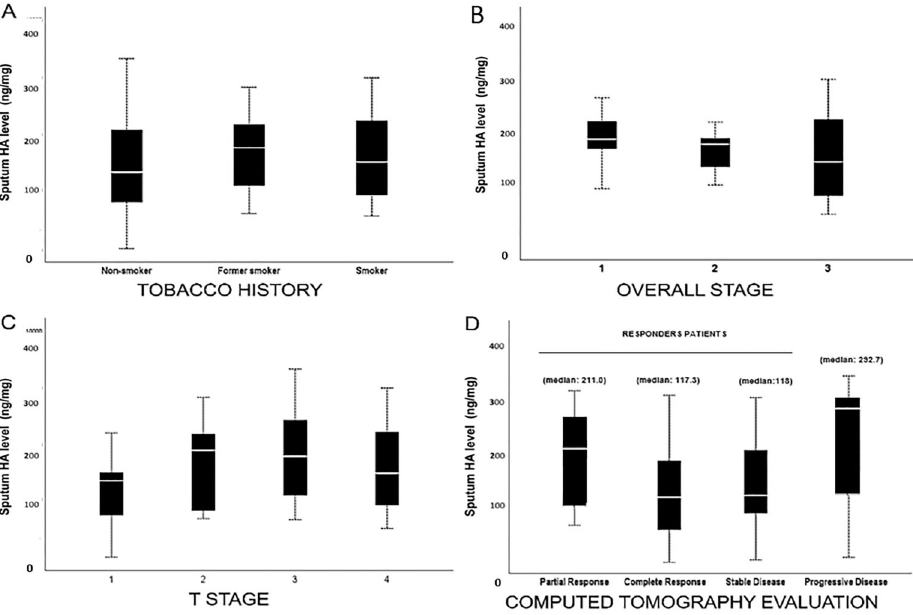
Figure 2. Relationships between sputum hyaluronan (HA, ng/mg, 7% NaCl) level and tobacco history ( A ), overall stage ( B ), Tstage ( C ), and tumor response evaluation by computed tomography scans, after systemic treatment, classi fi ed as partial response, complete response, stable disease (responder patients), or progressive disease, according to the response evaluation criteria in solid tumors (RECIST) ( D ). The solid bar represents the values of HA between the 25th and 75th percentiles, the white line indicates the median value, and the top and bottom brackets show the extreme values. Fisher ’ s exact test was used for analyses.